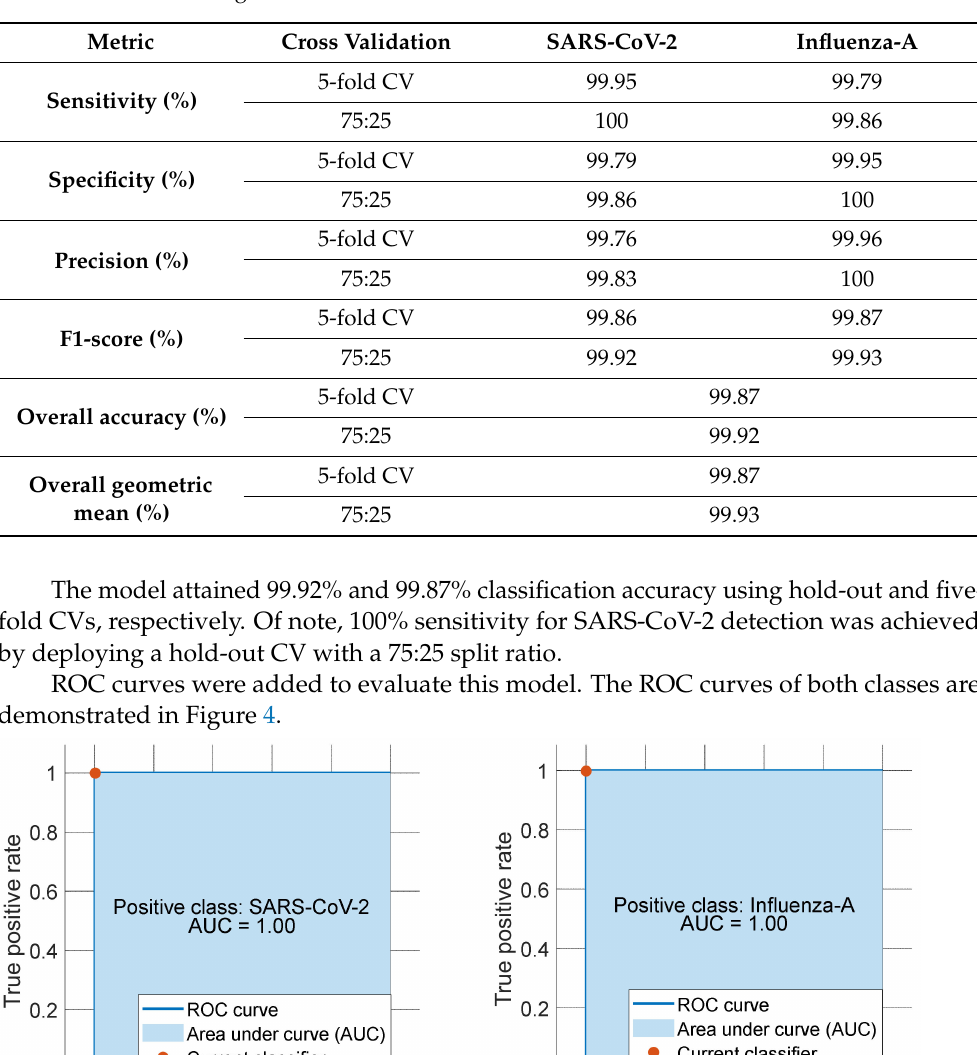
Table 2. Performance metrics for binary classification of viral protein sequences into SARS-CoV-2 versus Influenza-A using the HamletPat-based classification model.